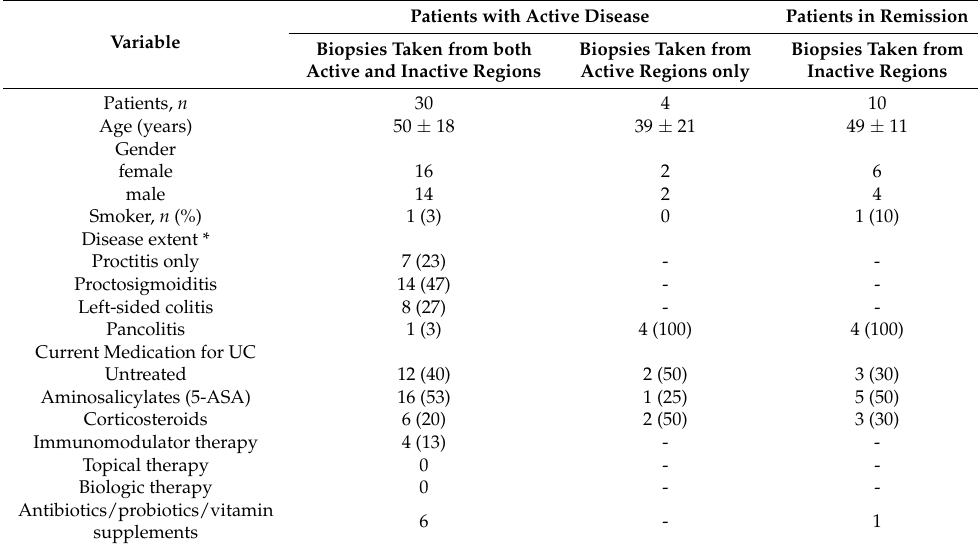
Table 1. Clinical characteristics of ulcerative colitis patients.